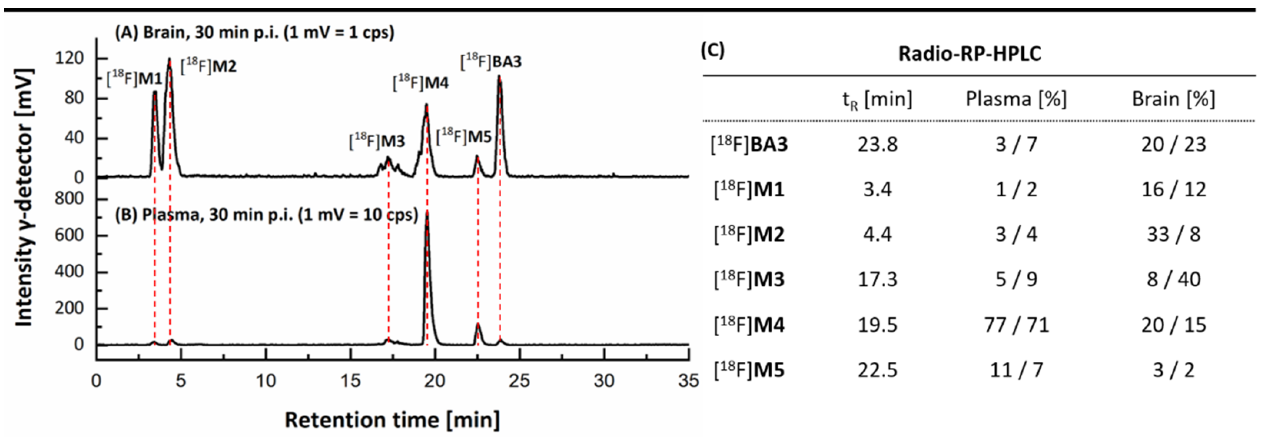
(Figure 4) five radiometabolites ([ 18 F] M1 -[ 18 F] M5 ) were detected in brain at 30 min p.i. In contrast, in plasma one single major radiometabolite, [ 18 F] M4 , amounting to 74%, was